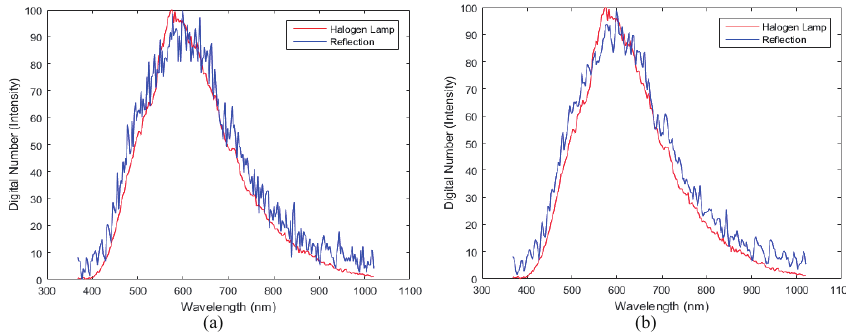
Figure 14. Comparison by the normalized spectral halogen lamp and reflection plate ( a ) without smoothing filter ( b ) with smoothing filter.